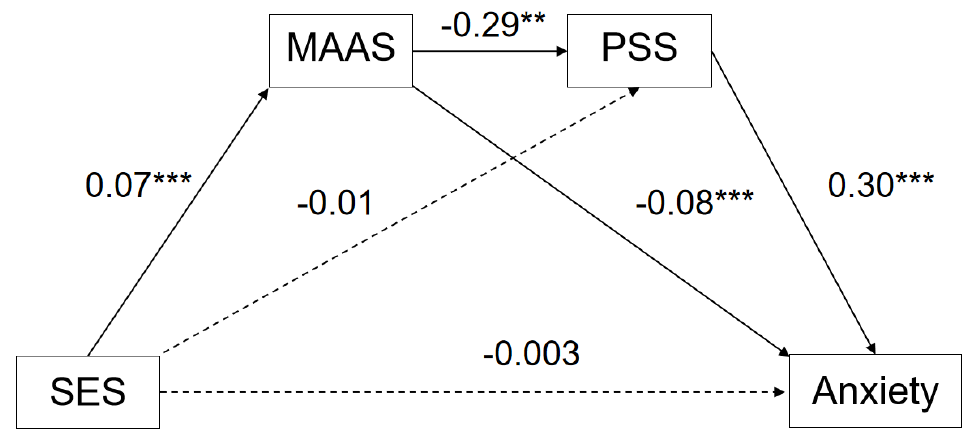
Figure 1. Serial Mediation Model of Socioeconomic to Internalizing Problems: Anxiety. ** p < 0.01. *** p < 0.001. Table 4. Analysis of mediation